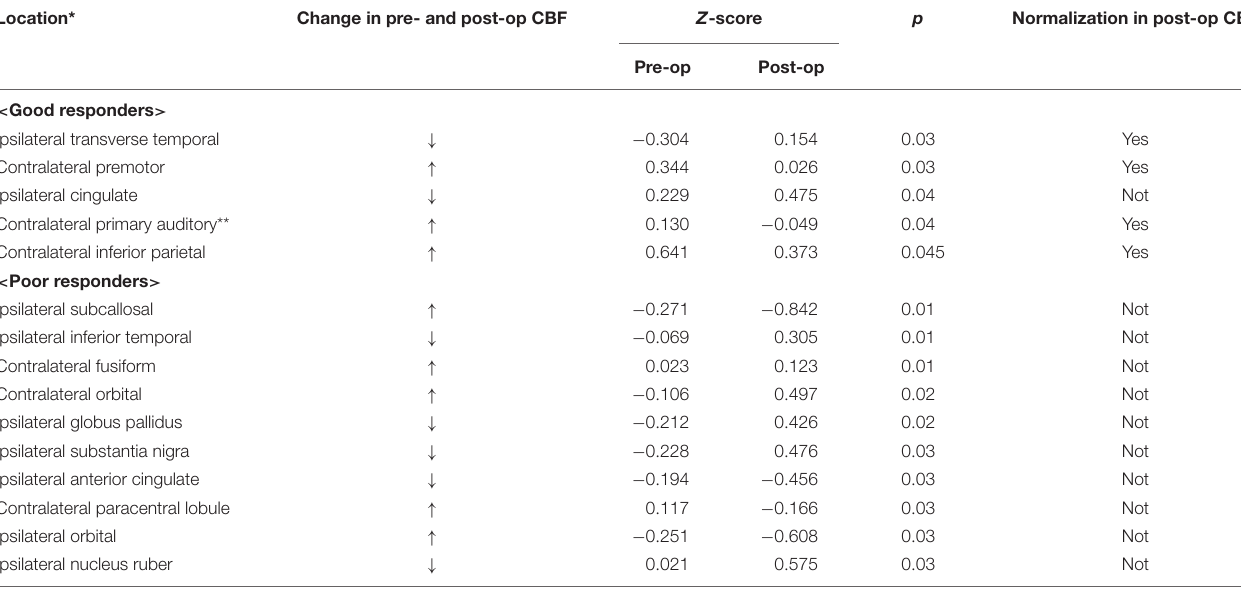
Patients were divided into good and poor responders in changes of Movement Disorder Society-Unified Parkinson’s Disease Rating Scale (MDS-UPDRS) part III total scores after surgery. *Only locations with significant changes in post-op CBF were extracted. **Primary auditory overlaps anatomically with frontal lobes. ↑ : increased CBF, ↓ : decreased